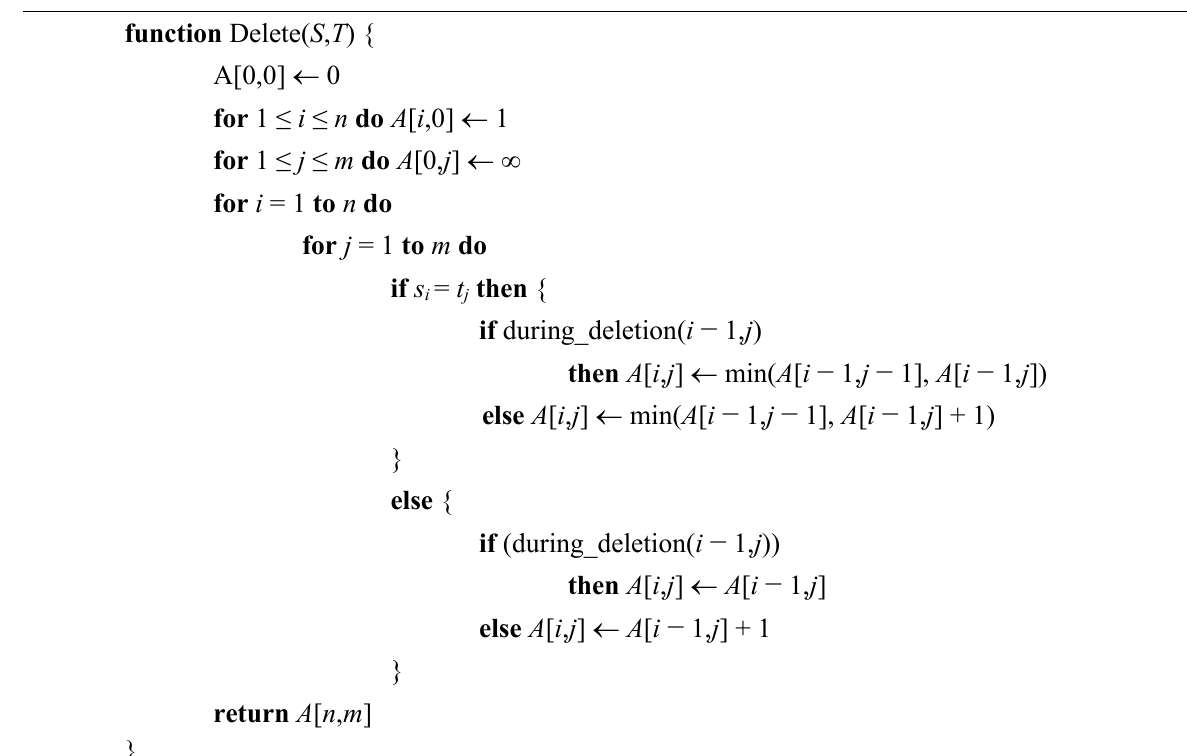
Algorithm 2. Edit distance with block